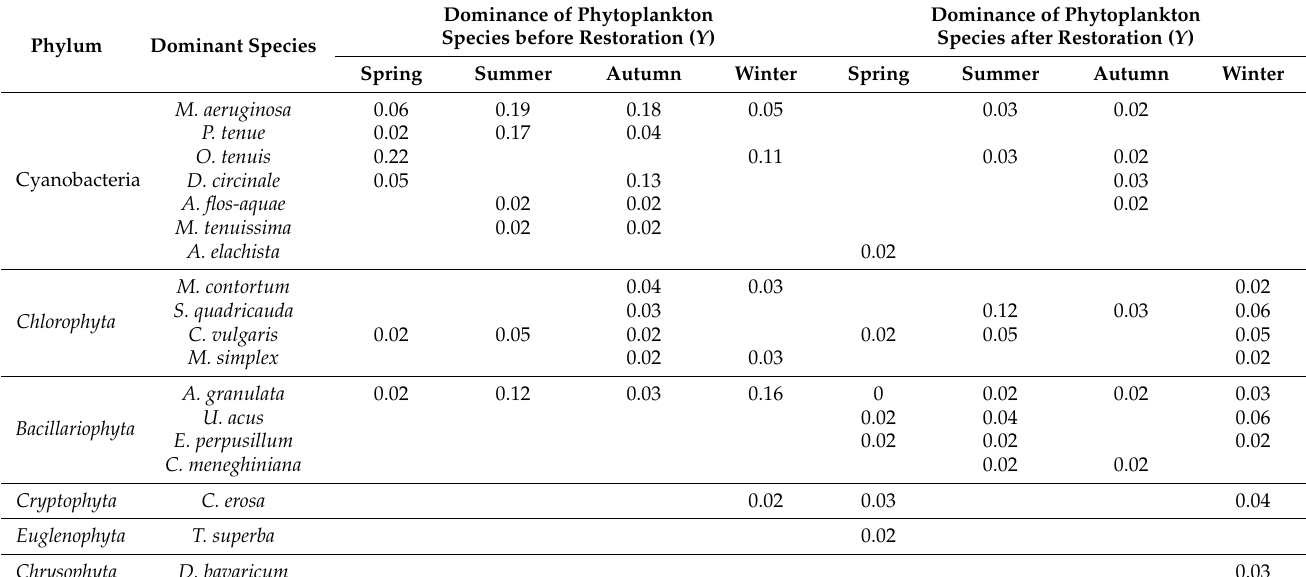
Table 2. Dominant species and temporal dynamics of